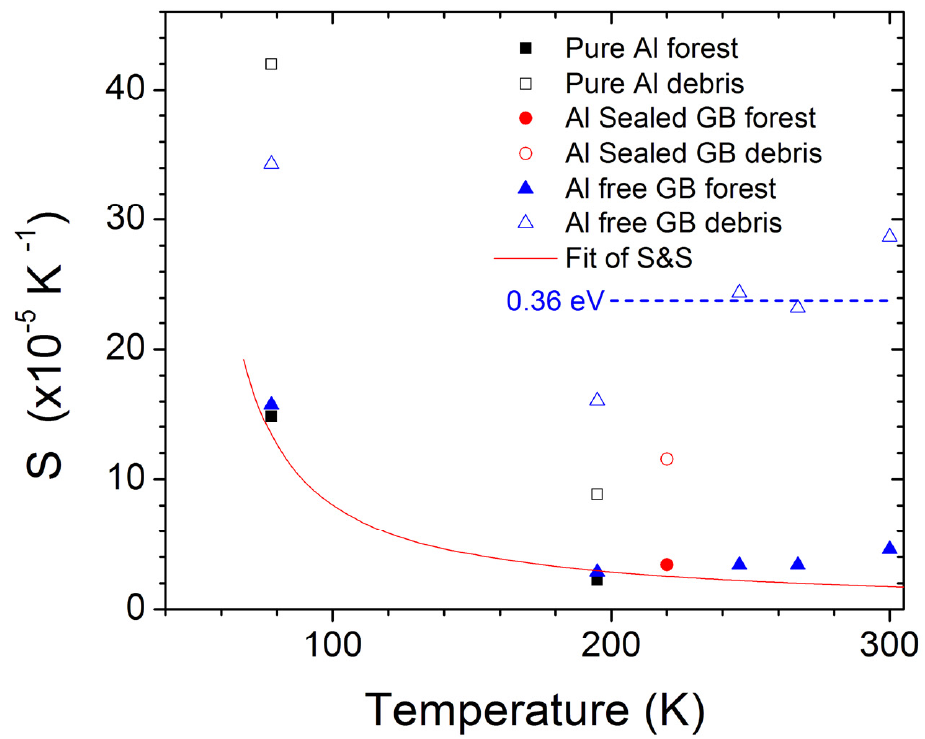
Figure 15. Plot of derived S for and S debris versus temperature. Dislocation-forest interaction is insensitive to purity whereas dislocation-debris is more sensitive. Note that S for data tend towards the fit-locus but it is larger inferring vacancy supersaturation is not zero.